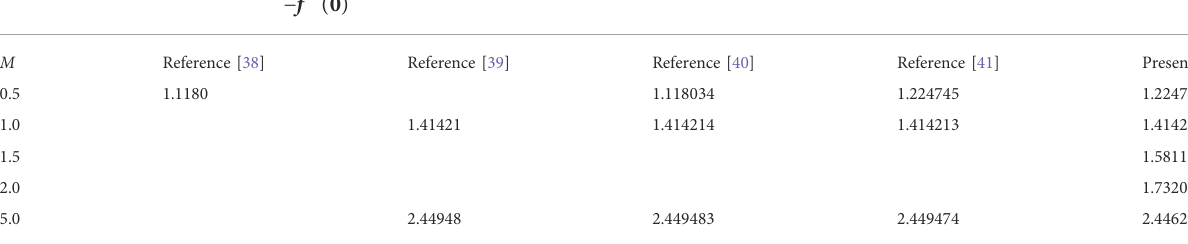
TABLE 2 Comparison values of − ~ f